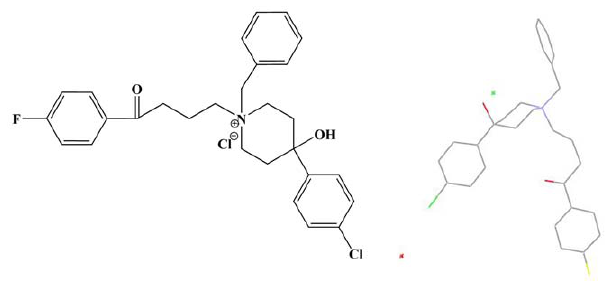
Figure 1. The chemical structure of 4(A), The molecular structure of 4